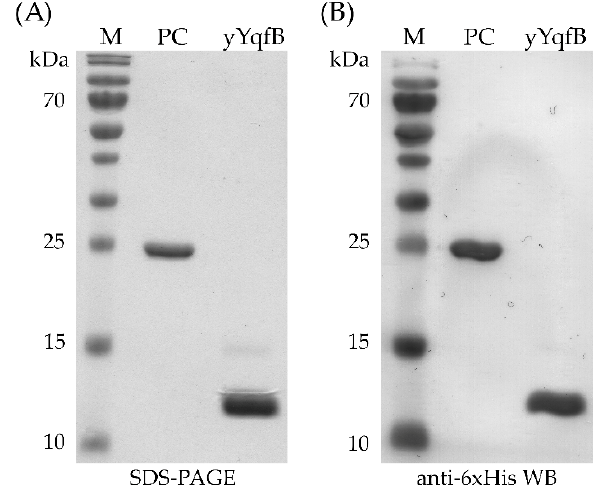
Figure 3. Analysis of YqfB produced in yeast P. pastoris (yYqfB). ( A ) Protein profile in SDS-PAGE, where M is the PageRuler Prestained Protein Ladder; PC is the 6xHis-tagged Penaeus monodon allergen Pen m4 –positive control for anti-6xHis Western blot analysis; yYqfB is the yeast produced E. coli YqfB; ( B ) Western blot analysis of described samples.